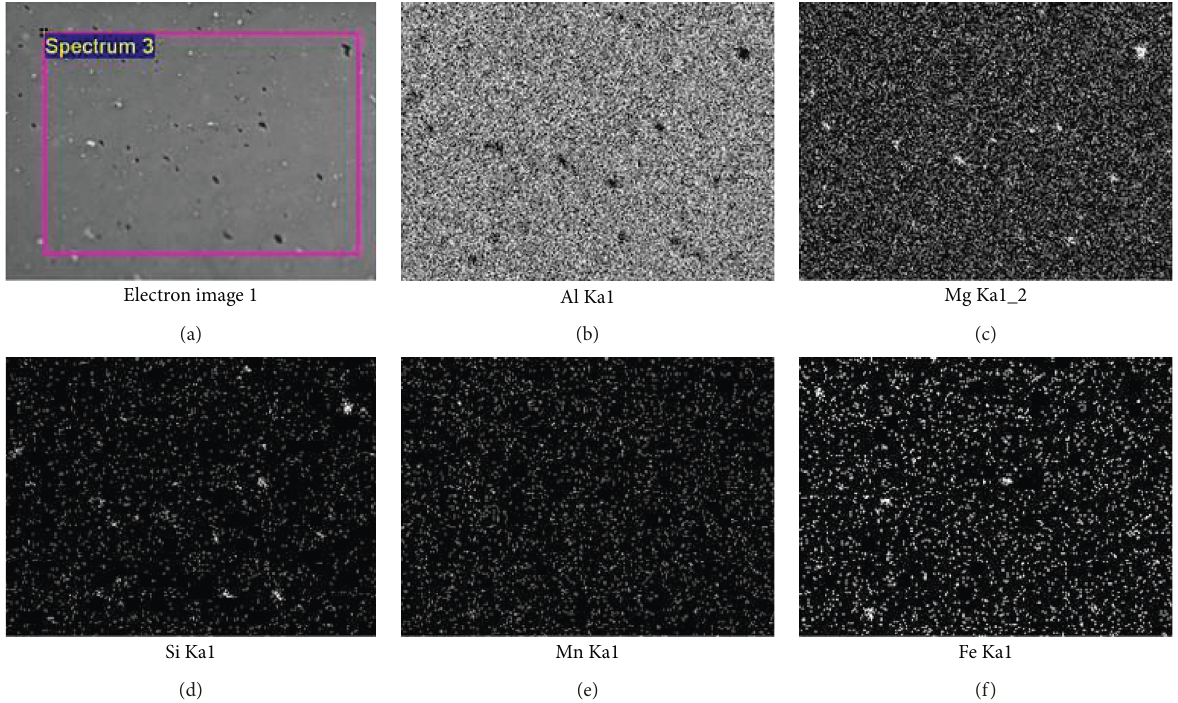
Figure 7: Low magnification observations and EDS elemental mapping analysis of the SZ of the sample welded at 140mm/min showing the distribution of various elements. (a) Scanned area; (b) Al; (c) Mg; (d) Si; (e) Mn; (f)